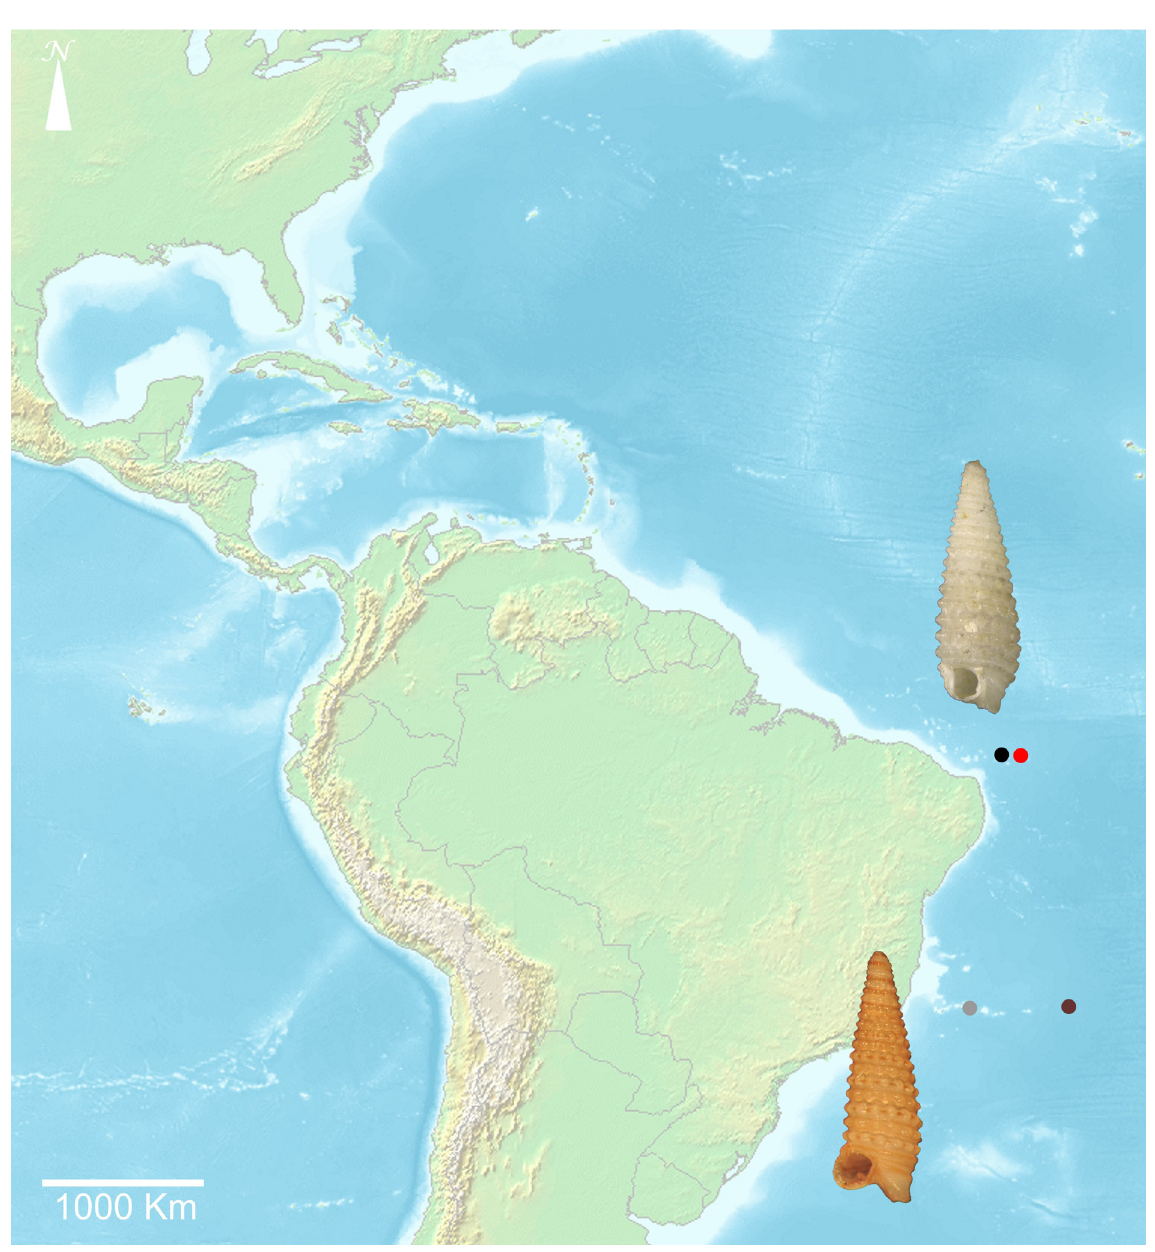
Fig. 51. Distribution map of Isotriphora uncia sp. nov. (red circle = type locality; black circle = additional locality) and Isotriphora tigrina Fernandes, Pimenta & Leal, 2013 (brown circle = type locality; gray circle =